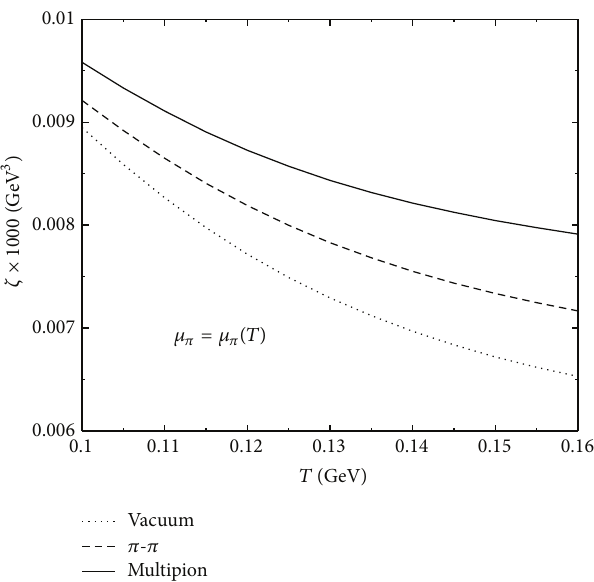
Figure 7: The bulk viscosity as a function of temperature for a chemically frozen pion gas. The dashed and solid lines correspond to the use of in-medium cross-sections in (84) for 𝜋𝜋 and multipion loops, respectively. The dotted line represents the vacuum